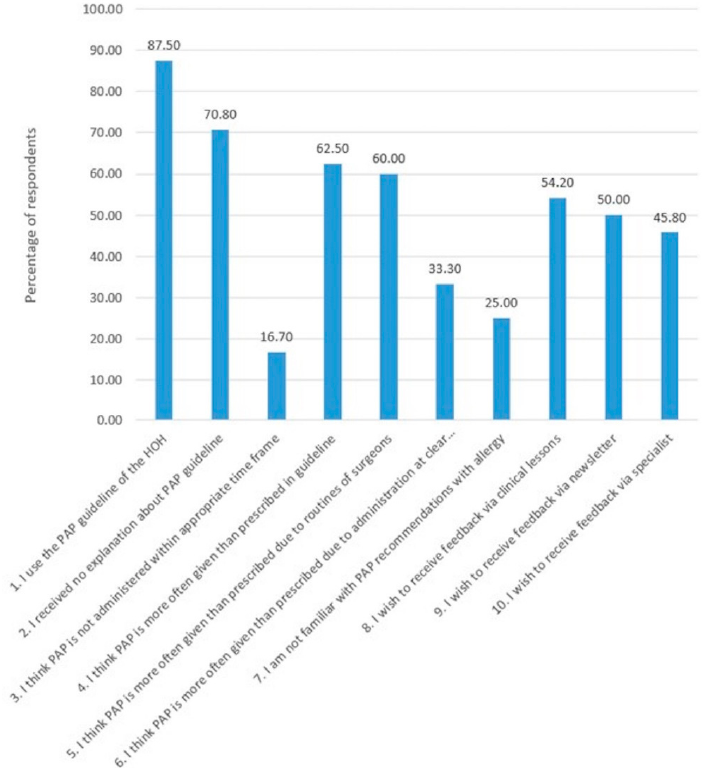
Figure 2. Barriers for PAP guideline adherence represented for the percentages of respondents. were answered by 15 respondents. The remaining questions were answered by 24